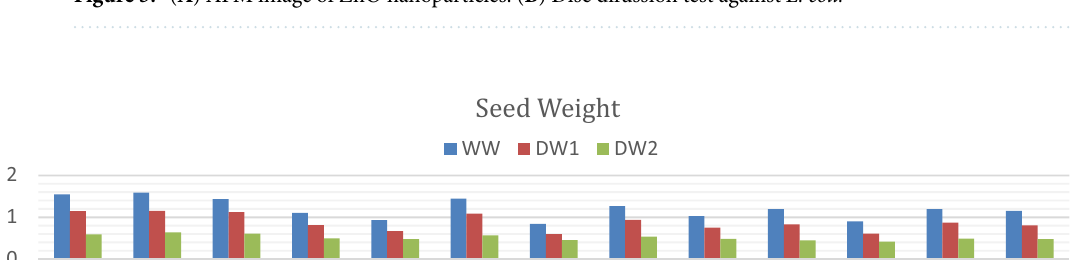
Figure 5. ( A ) AFM image of ZnO nanoparticles. ( B ) Disc difussion test against E. coli.